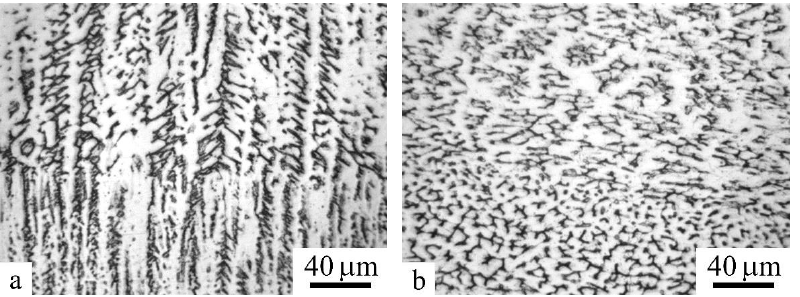
Figure 7. Microstructure of the metal at a boundary between the deposited layers in a sample produced without ( a ) and with ( b ) cold peening.